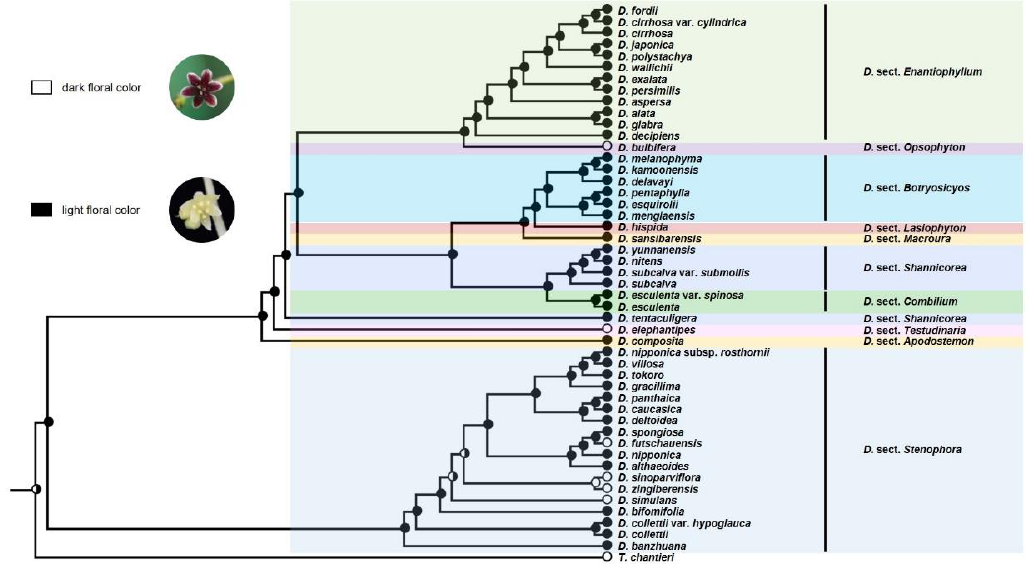
Figure 5. Ancestral character state reconstruction for the floral color using the parsimony method.